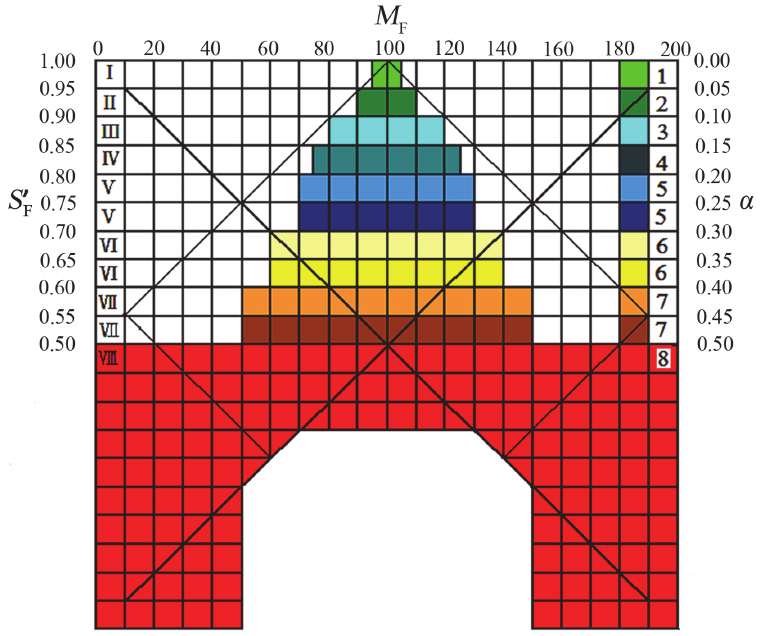
Fig 2. The quality pyramid and warning gate for TCM/HM based on SQRFM. S 0 F : the qualitative ratio similarity; M F : the corrected quantified ratio similarity; α : the coefficient of variation.